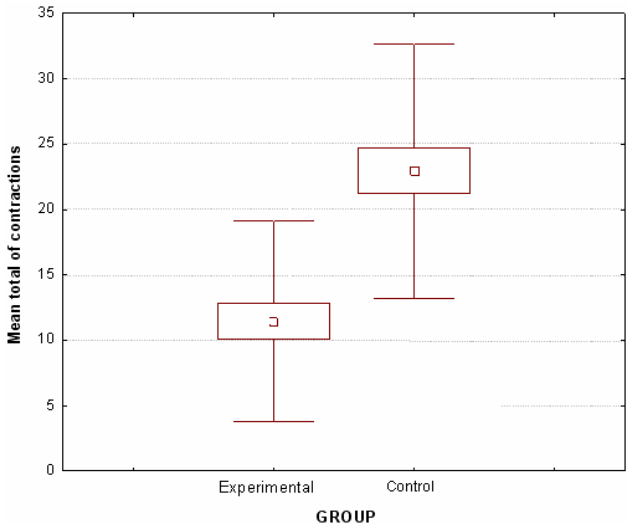
FIGURE 1 - The mean total of abdominal contractions in the groups